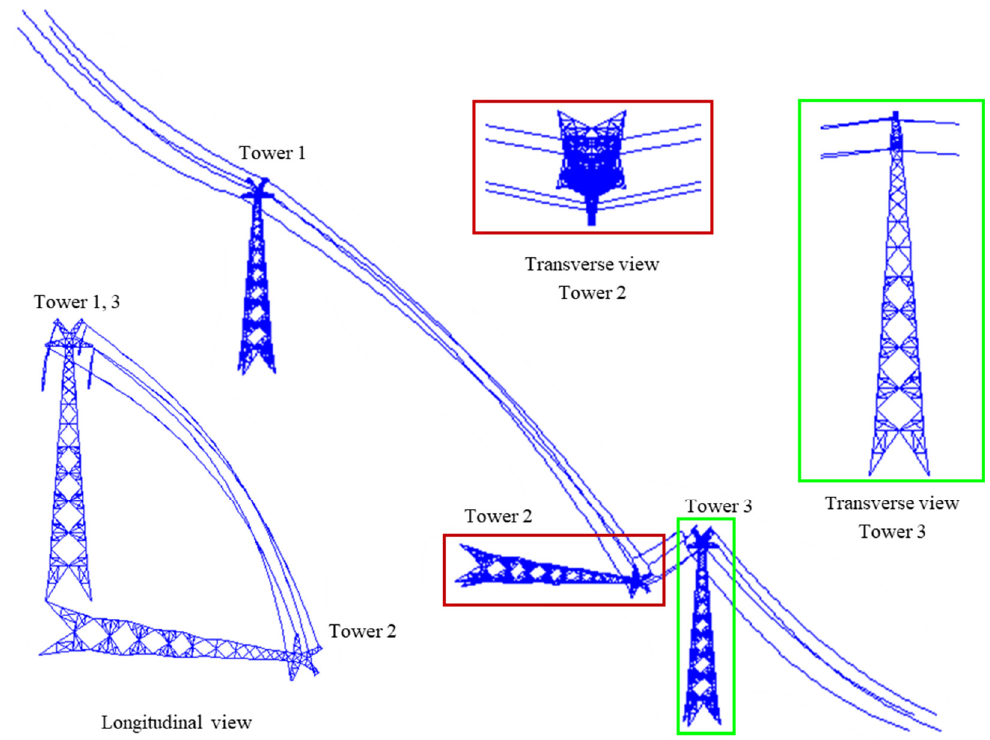
Figure 13. Behavior of the transmission tower-line structure at t = 14 s under Case 1.